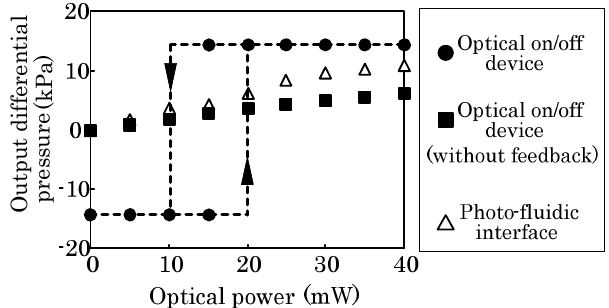
Relation between optical power and output pressure of optical on/off